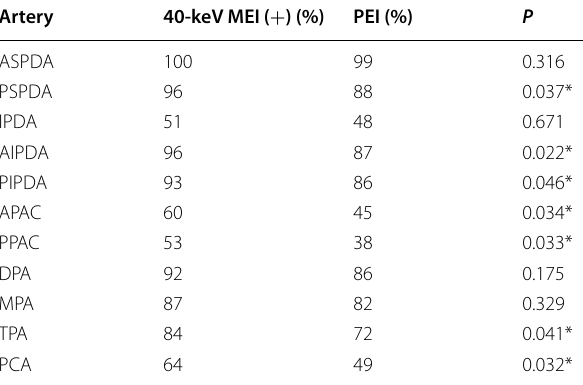
*40-keV MEI ( ) > PEI in the frequency of visualization of arteries ( p < 0.05) + ASPDA, anterior superior pancreaticoduodenal artery; PSPDA, posterior superior pancreaticoduodenal artery; IPDA, inferior pancreaticoduodenal artery; AIPDA, anterior inferior pancreaticoduodenal artery; PIPDA, posterior inferior pancreaticoduodenal artery; APAC, anterior pancreaticoduodenal arcade; PPAC, posterior pancreaticoduodenal arcade; DPA, dorsal pancreatic artery; MPA, magnificent pancreatic artery; TPA, transverse pancreatic artery; PCA, caudal pancreatic